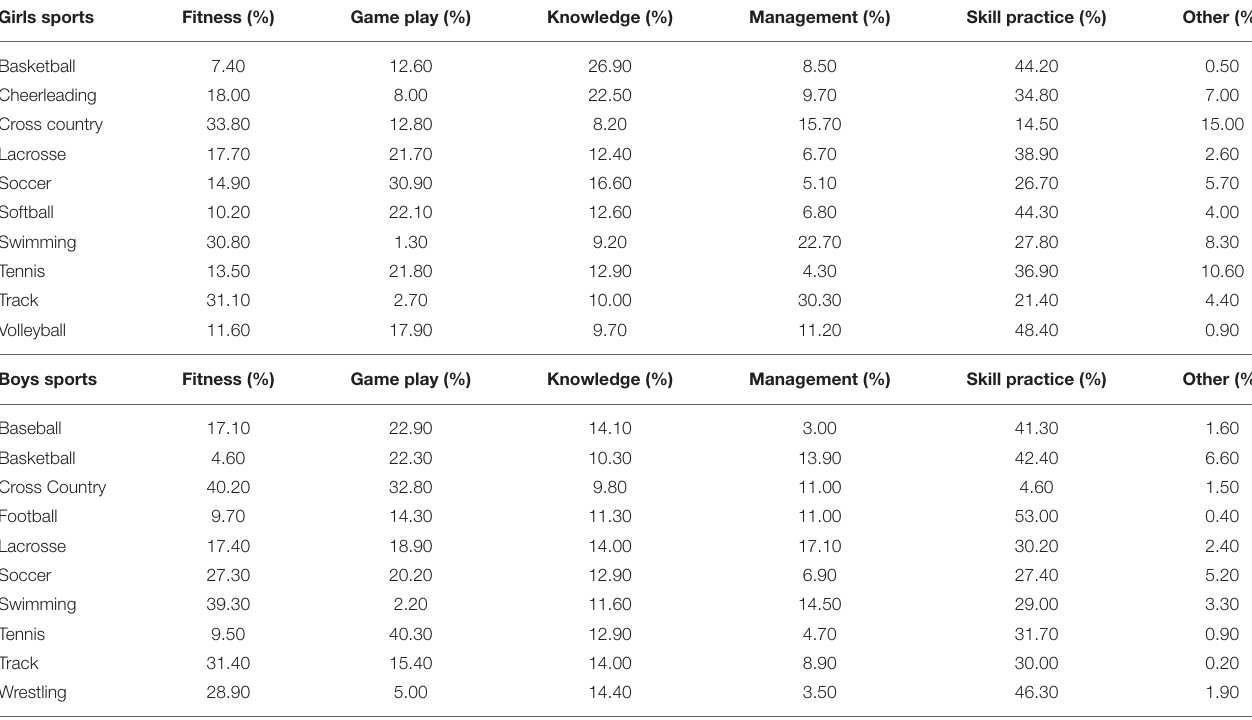
TABLE 5 | Percent of practice time for sports by gender.